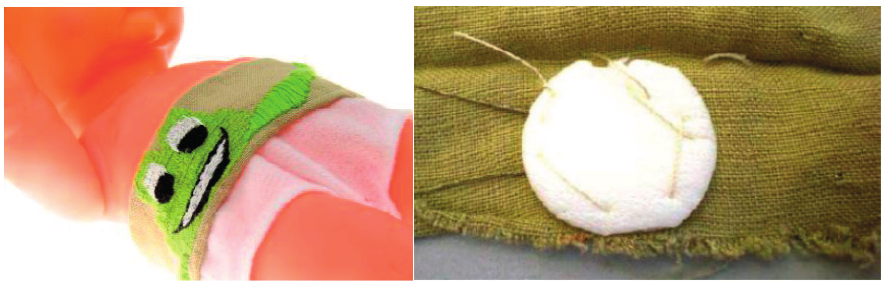
Figure 9. The prototype belt on a baby doll ( left ); and the isolation of the sensor in the belt ( right ) [10]. Copyright © 2010 Association for Computing Machinery, Inc.